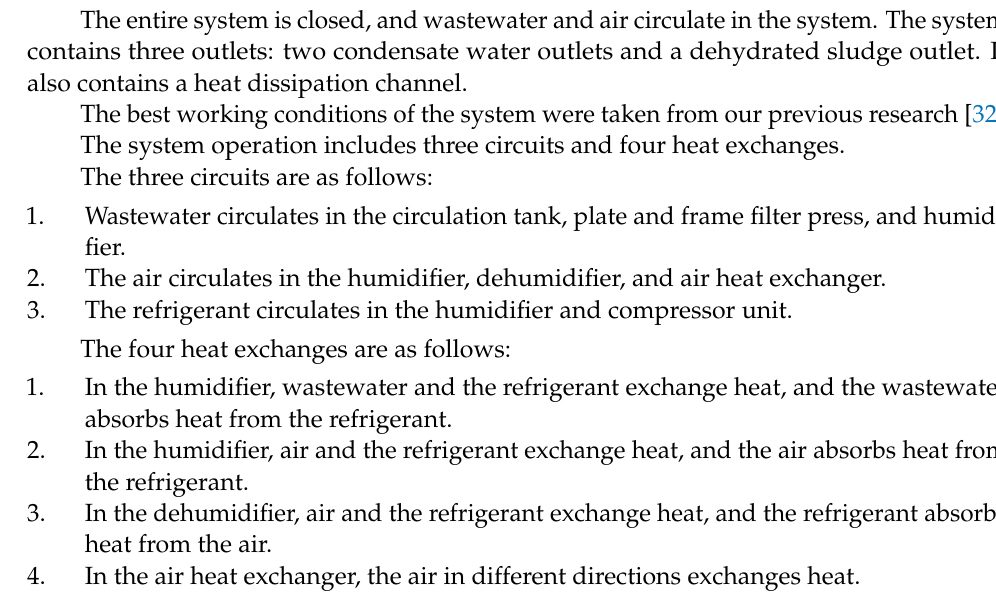
Figure 1. System schematic diagram.